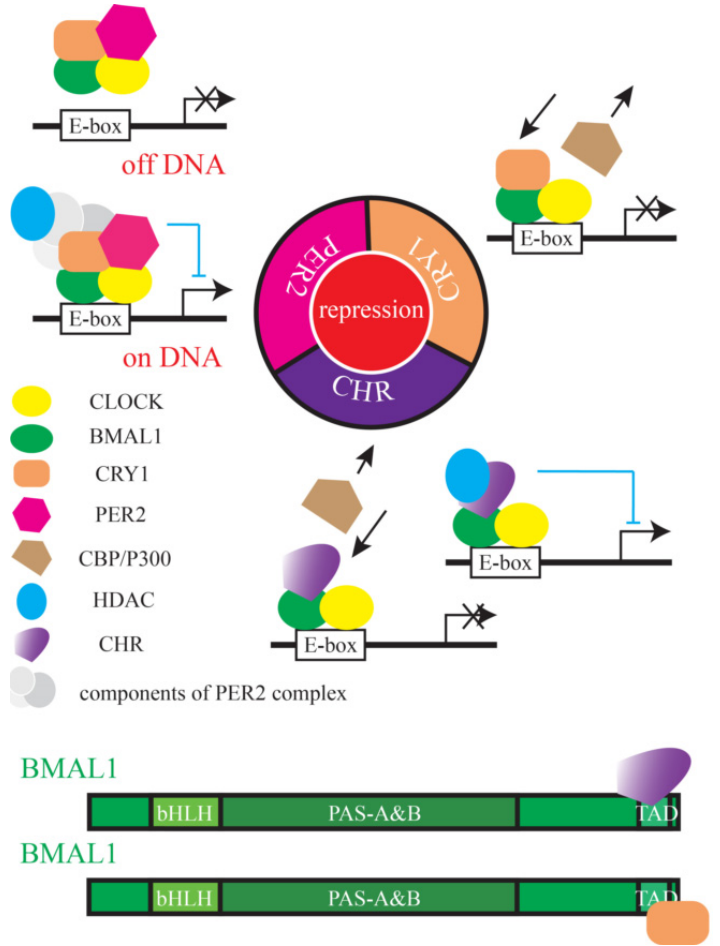
Figure 7. A molecular repression model of how CHR functions as a repressor in the mammalian circadian clock.During repression, PER2 can form large complexes to recruit HDAC (defined in the Abbreviations) or displace the B/C complex away from chromatin; CRY interacts with BMAL1 to restrict it from transcriptional co-activators; CHR binds to BMAL1 to either recruit HDAC or disrupt the recruitment of co-activators. PER proteins associate with the PAS domain of BMAL1; CRY1 binds to the TAD domain in the distal C-terminus of BMAL1.At different circadian phases, CHR binds to the TAD domain in the distal C-terminus of BMAL1. Under these different interacting modes, PER, CRY, and CHR function differentially to repress the circadian clock.